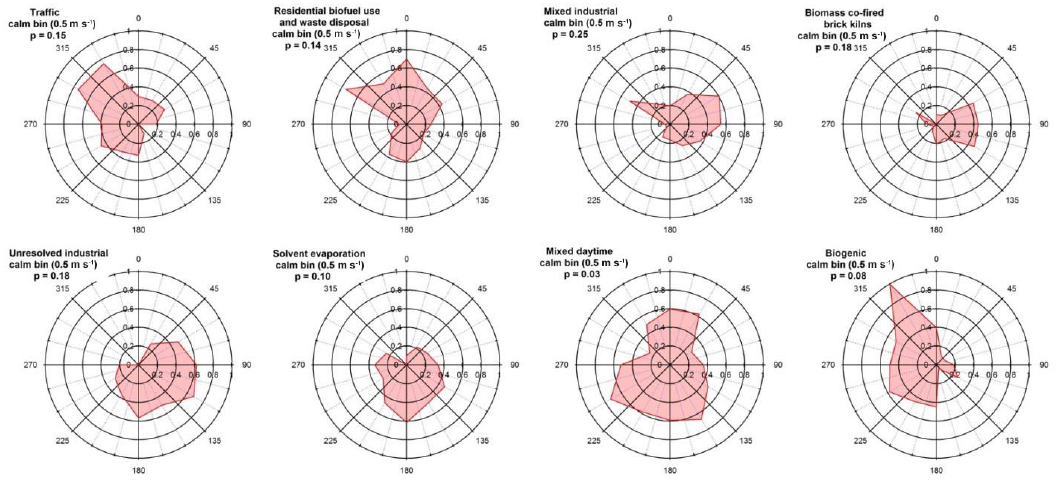
Figure 12. Conditional probability function (CPF) plots for all source factors resolved by PMF showing wind directional dependency of different source categories.